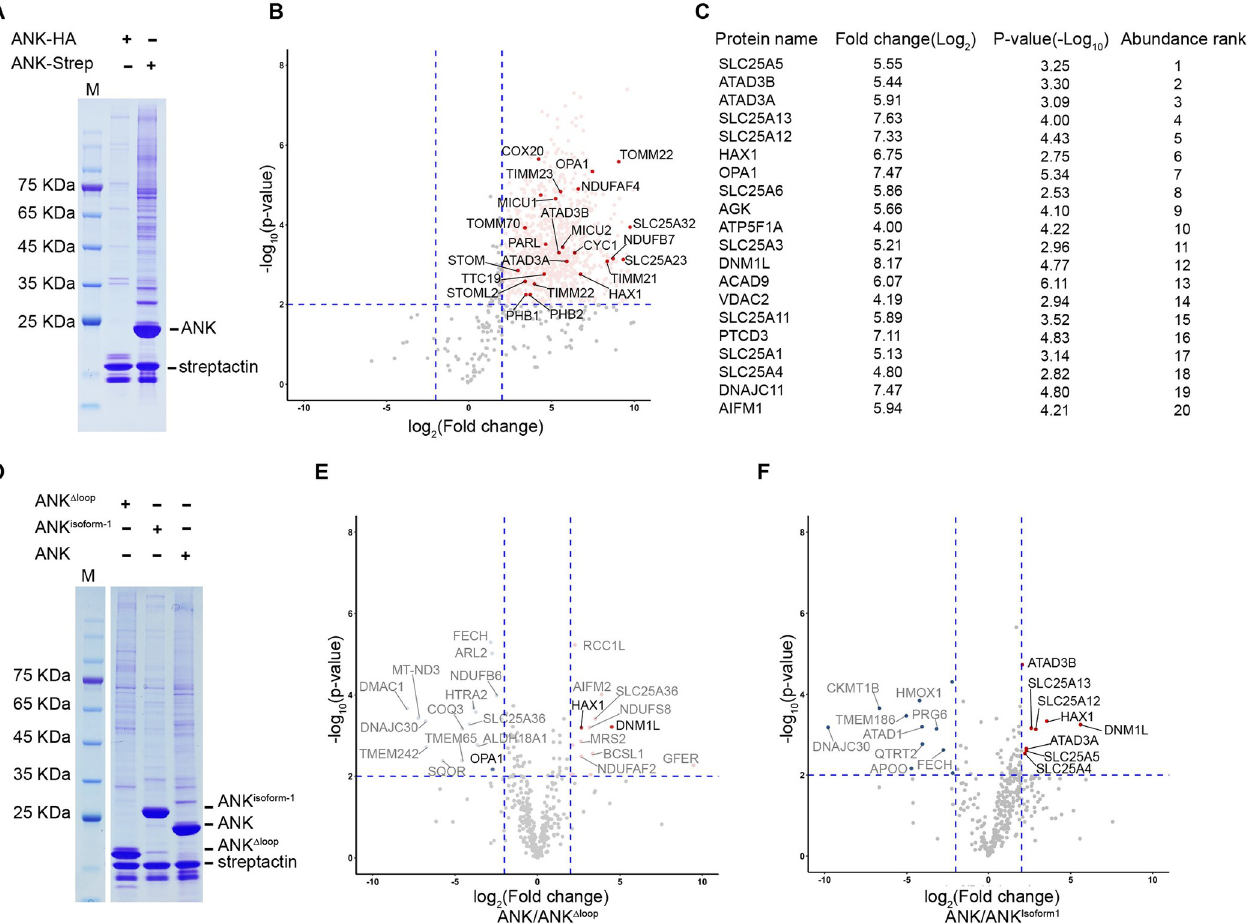
Fig 6. The mitochondrial interactome of the ANK domain. ( A ) HEK-293F cells expressing the MTS-ANK-HA or MTS-ANK-Strep constructs were subjected to pulldown experiments with Strep resins. Precipitates were analyzed by SDS-PAGE, Coomassie blue staining, and MS. ( B ) Volcano plot showing the mitochondrial proteins co-precipitated with MTS-ANK-Strep. A total of 935 proteins that were enriched in the MTS-ANK-Strep are labeled in light red. The potential substrates, previously reported to be most affected by CLPB -knockout, are highlighted in red. A relatively stringent criterion (fold-change > 4 and p -value < 0.01) were used for enrichment analysis (3 biological replicates), indicating with blue dashed lines (S5 Data). ( C ) Top 20 proteins in OM, IMS, and IM are listed based on the ranking of protein abundances (S4 Table). ( D ) HEK-293F cells expressing the MTS-ANK-Strep, MTS-ANK Δ loop -Strep, and MTS-ANK isoform1 -Strep constructs were subjected to pulldown experiments with Strep resins. Precipitates were analyzed by SDS-PAGE, Coomassie blue staining, and MS. ( E, F ) Volcano plot showing the fold change of the OM, IMS, and IM mitochondrial proteins in MTS-ANK-Strep compared to MTS-ANK Δ loop -Strep (E) or MTS-ANK isoform1 -Strep (F). Proteins in the top 20 list (C) were heighted in red (S6 and S7 Data). IMS, intermembrane space; MS, mass spectrometry; MTS, mitochondrial targeting signal.